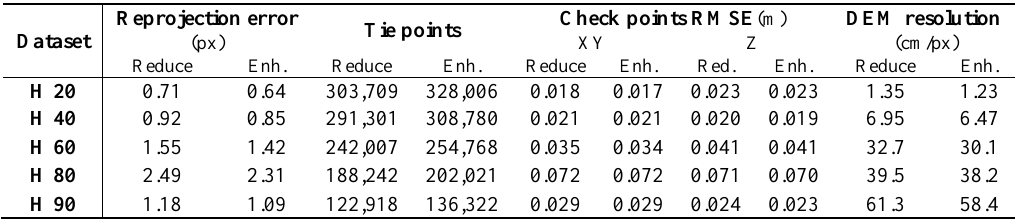
Table 4 . The results of UAV products for different dataset. The results indicated that the number of tie points extracted after using the proposed contrast-enhancement technique to low- contrast images increased by approximately 10%, increasing the density of the point cloud. Contrast enhancement of the images resolution of the digital elevation model.